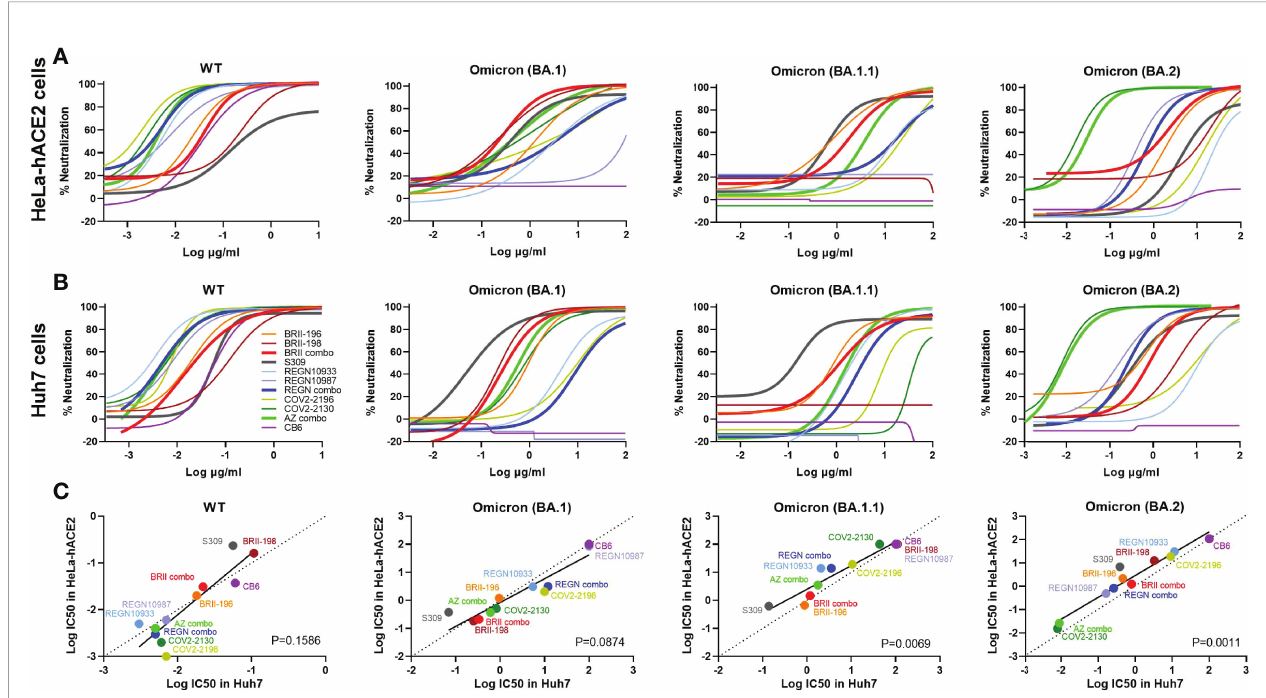
FIGURE 1 | Substantial reduction in antibody neutralization to Omicron BA.1, BA.1.1, and BA.2. Neutralizing activity of each therapeutic antibody and their designated combinations to wildtype (WT), Omicron BA.1, BA.1.1, and BA.2 pseudoviruses analyzed in (A) HeLa cells expressing human ACE2 (HeLa-hACE2) and (B) in Huh7 cells. WT and Omicron pseudoviruses were tested against serial dilutions of each antibody and relevant combinations. Neutralizing activity was de fi ned as the percent reduction in luciferase activities compared to no antibody controls. Results were derived from two independent experiments and each included two technical replicates. (C) Correlation between Log IC50 for all tested mAbs and their clinical-relevant combinations in HeLa-hACE2 and Huh7 cells. The R 2 and P values of correlation were 0.7963 and 2.2e-4 for WT, 0.8768 and 2.2e-5 for BA.1, 0.9017 and 7.9e-6 for BA.1.1, and 0.9374 and 1.0e-6 for BA.2, determined by two-tailed Spearman correlation. Linear regression of experimental Log IC50 was estimated (solid line) and compared with a hypothetical regression (dotted line) for assumption of equal IC50s in both HeLa-hACE2 and Huh7 cell lines. No signi fi cant differences were detected between experimental and hypothetical regression for WT (P = 0.1586) and BA.1 (P = 0.0874), but signi fi cantly lower levels in Huh7 cells was found than in HeLa-hACE2 cells for BA.1.1 (P = 0.0069) and BA.2 (P =